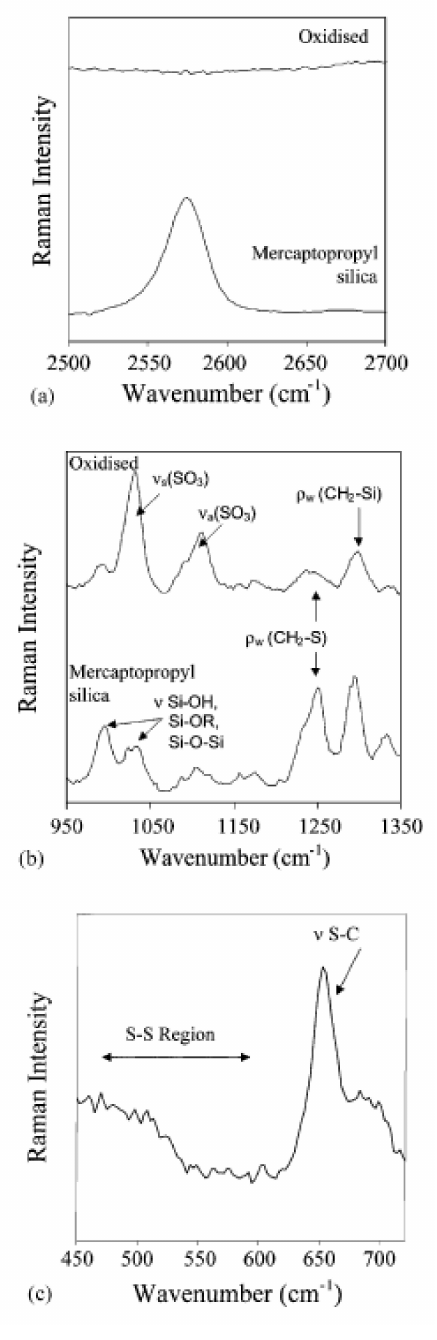
Figure 18. Raman spectra of mercaptopropyl silica before and after oxidation ( a ) S-H stretching region; ( b ) S-O stretching region; ( c ) S-S stretching region from ref. [94]. Reprinted with permission from ref. [94]. Copyright 2002